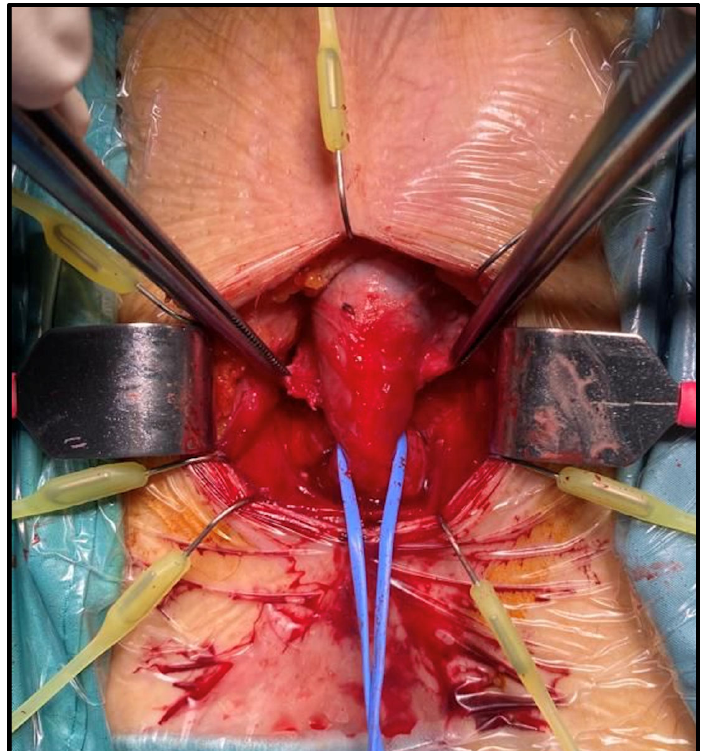
Figure 3. Urethra after completed dissection with attached external layer of tunica albuginea.